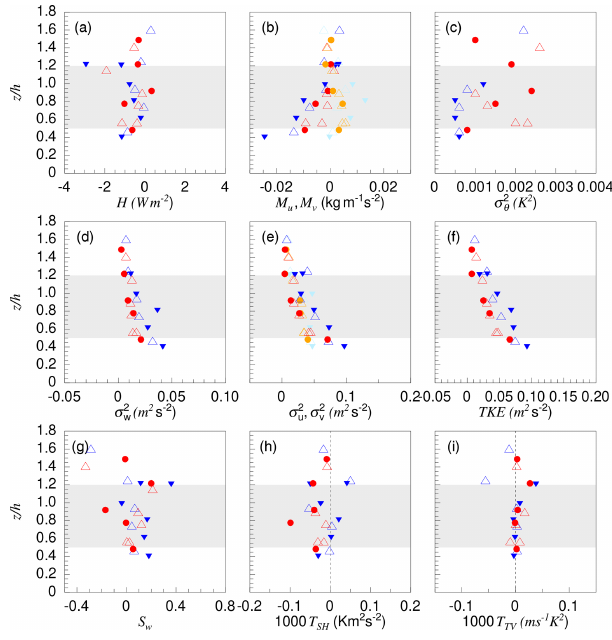
Figure 13. Turbulence statistics for the lowermost cloud layer based on the horizontal flight legs of 20 June 2017 obtained from Polar 5 (blue symbols) and Polar 6 (red symbols). The results re- fer to the two blue and red northernmost flight legs of the aircraft (see Fig. 11). Closed (open) symbols refer to the northern (south- ern) positions. Altitude is normalized by the cloud-top height for Polar 5 h = 190m (north) and h = 225m (south) and for Polar 6 h = 250m (both positions). The bright symbols (light blue and or- ange) refer to M v and σ 2 v , while the dark (red and blue) symbols in the corresponding panels refer to M u and σ 2 u